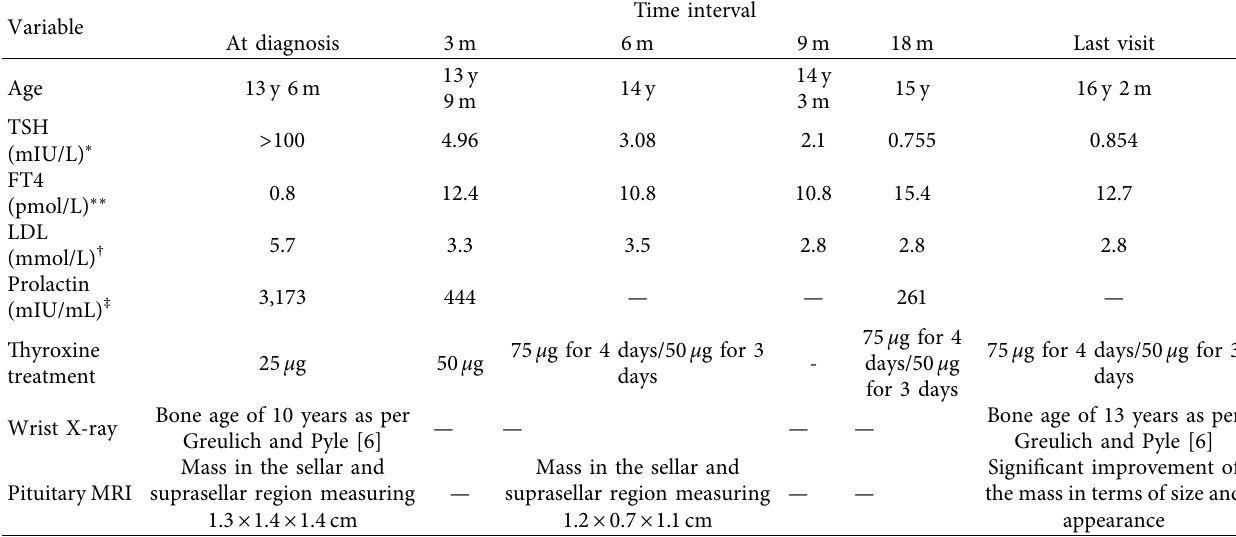
Table 1: Biochemical and radiological findings and thyroid hormone doses at diagnosis and during follow-up.